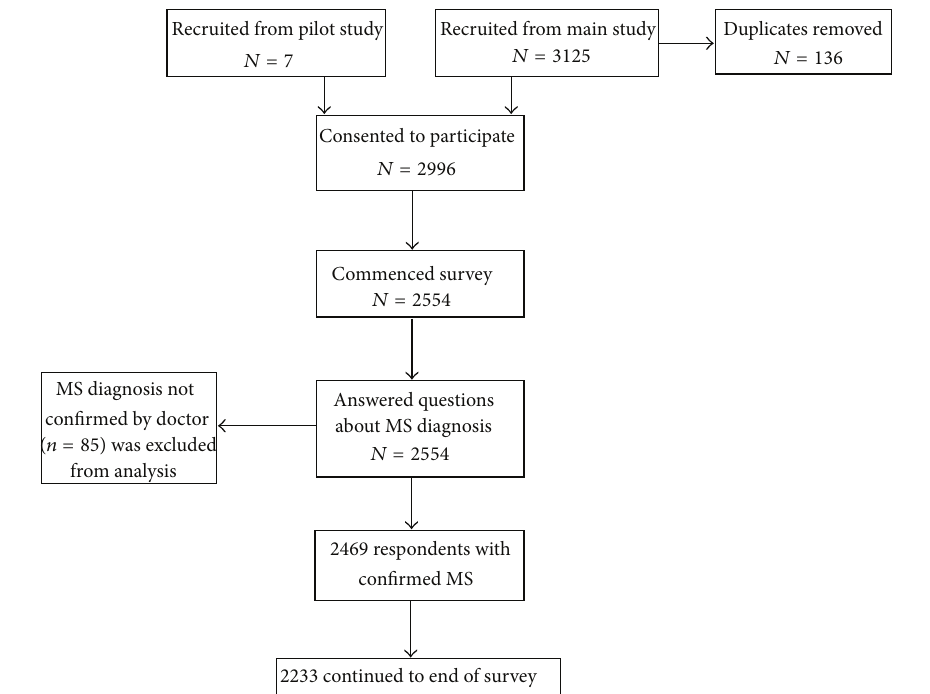
Figure 1: Participant study inclusion